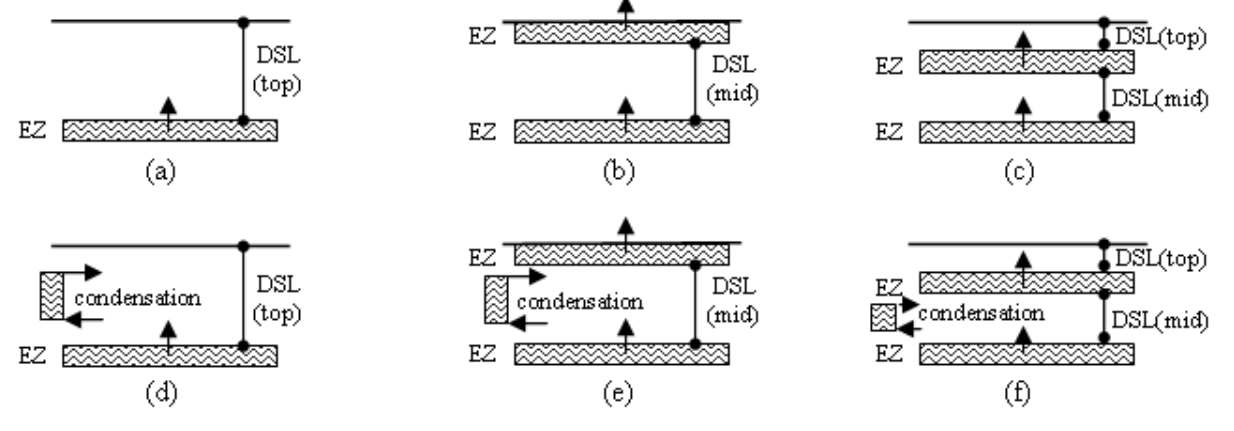
Figure 1. Possible distributions of dry soil layer (DSL) and evaporation zone (EZ) within a soil profile for situations of: ( a ) continuously drying; ( b ) drying and wetting; ( c ) drying, wetting, and drying; ( d ) continuously drying with condensation/re-evaporation; ( e ) drying and wetting with condensation/re-evaporation and ( f ) drying, wetting and drying with